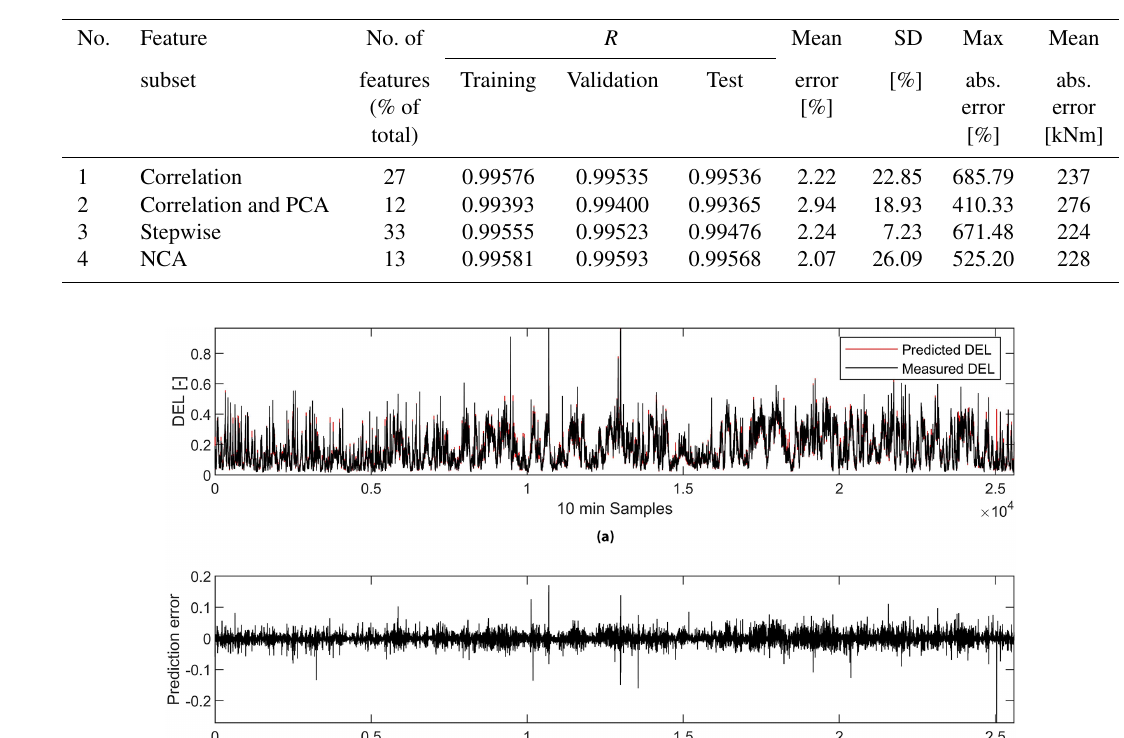
Table 3. Summary of results from neural networks for the complete year considering all operational modes.